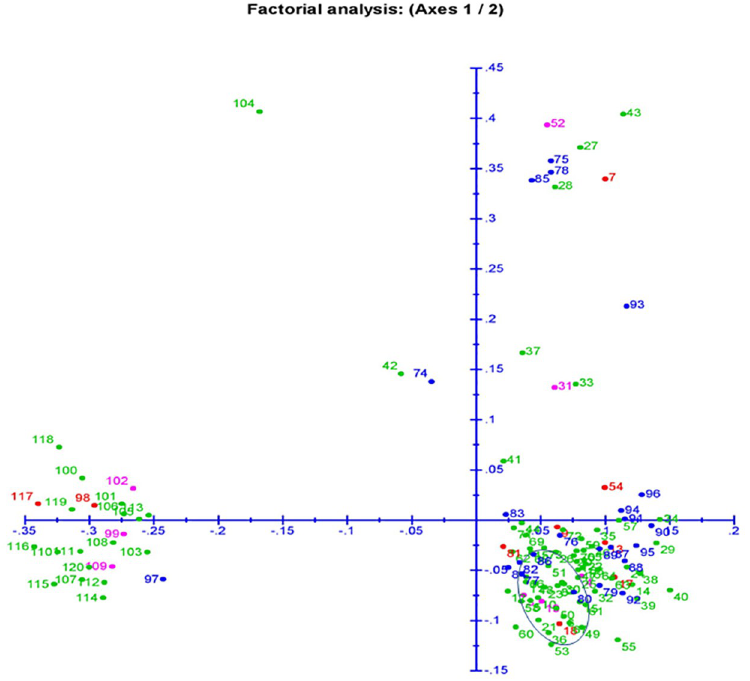
Fig 7. Principal coordinate analysis (PCoA) of 120landraces present in the panel population for 6 physiological traits using 136 molecular markers. The dot numbers in the figure represent the serial number of the genotypes enlisted in Table 1. The numbers are coloured on the basis of sub-populations obtained from structure analysis (SP1: Blue; SP2: pink; SP3: green and Admix: red).